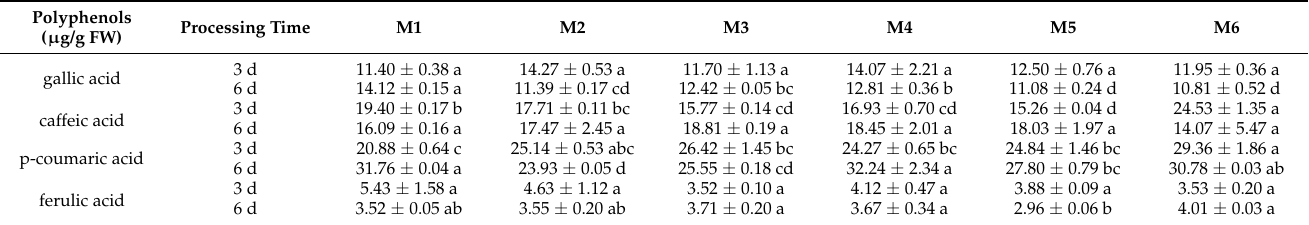
Table 2. The changes in polyphenol fractions of mung bean sprouts sprayed with different concentra- tions of naringin after 3 and 6 days of storage, the unit is µ g/g FW. Three days: results of treatment after storage for three days; six days: results of treatment after storage for six days. Data (Means ± SD) followed by the different letter in the same line indicate statistically significant difference ( p < 0.05).